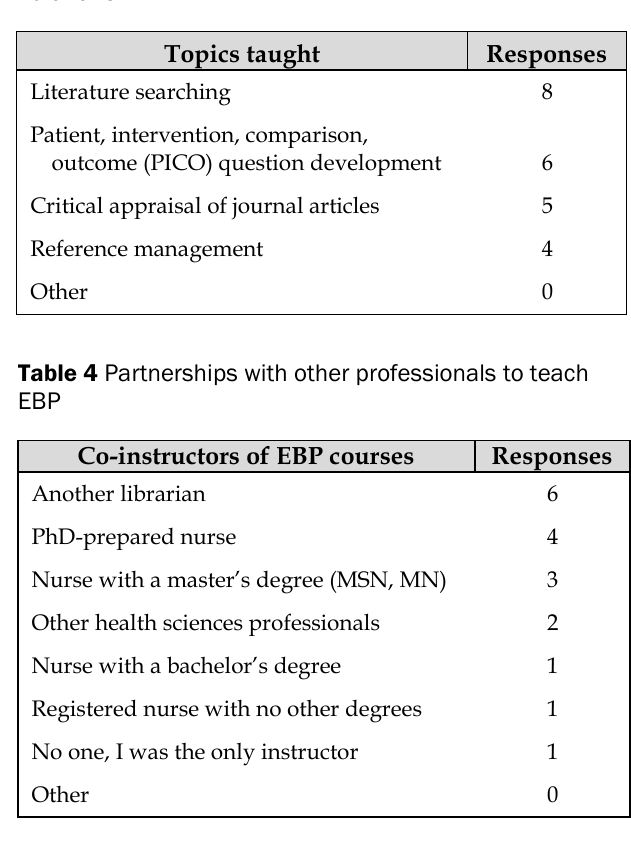
Table 3 Evidence-based practice (EBP) topics taught by librarians